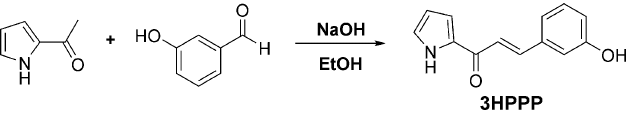
Figure 5 Synthetic route towards 3-(3-hydroxyphenyl)-1-(1 H -pyrrol-2-yl)prop-2- en-1-one ( 3HPPP ).